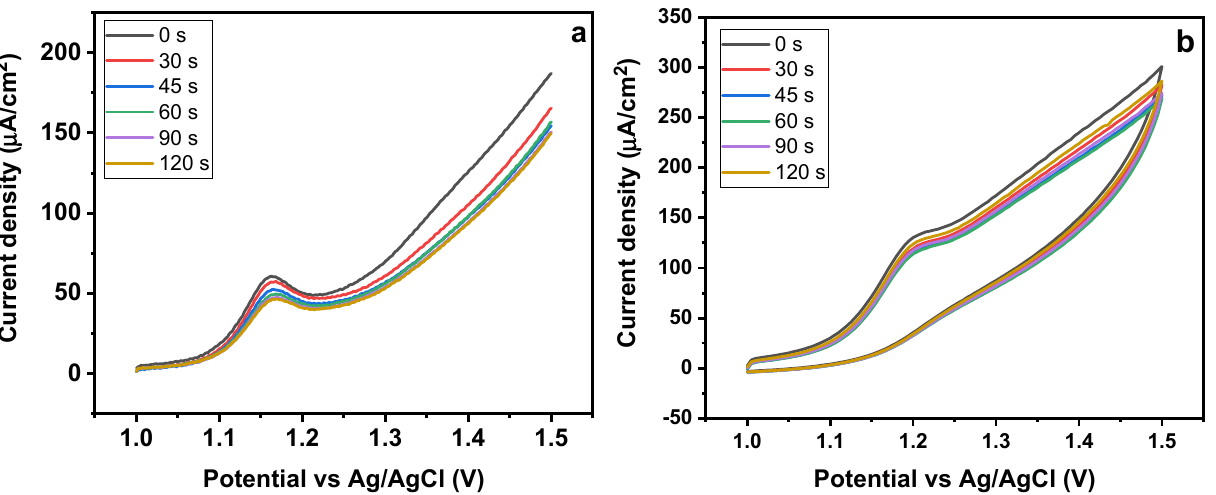
Figure 10. Effect of time on ( a ) CV and ( b ) SWAdASV for Fe 3 O 4 @MIP/CPE sensors (pH 7, scan rate 50 mV/s).